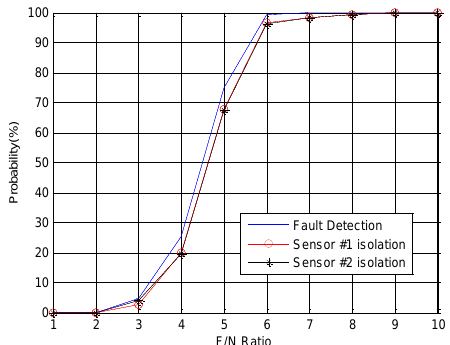
Figure 14. (CASE2) Double faults detection and isolation performance of sensor 1 and 2.